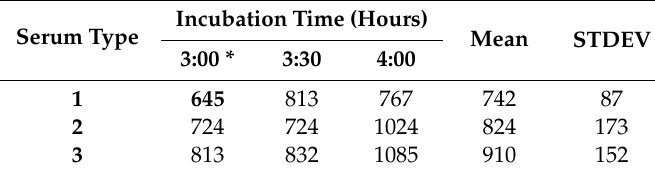
Table 5. Impact of the delay in adding cells after the three hours of incubation of the sera with poliovirus on the MPBN assay results.